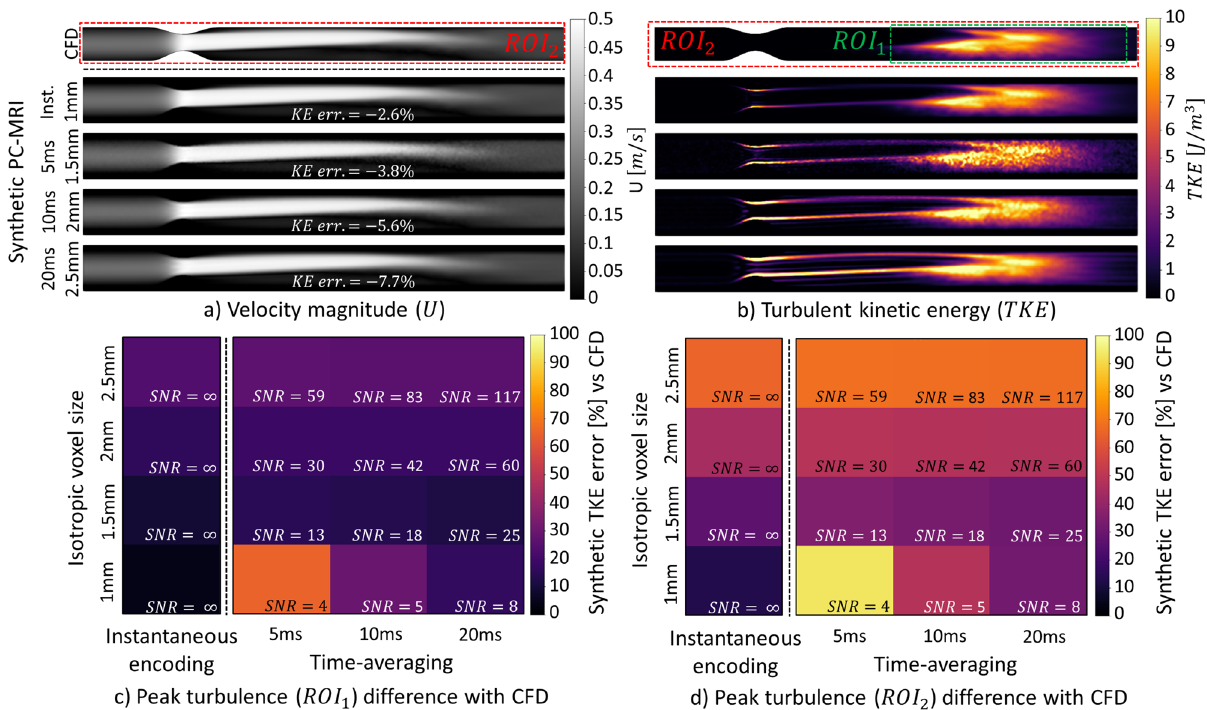
Figure 2. Impact of SNR and spatiotemporal resolution on velocity and turbulent kinetic energy for a 75% eccentric stenosis and steady flow. Magnitude of velocity ( U ) ( a ) and turbulent kinetic energy ( TKE ) ( b ) for varying voxel sizes, time averaging and, correspondingly, signal-to-noise ratios (SNR) are shown. The percentage error in total TKE as a function of spatial resolution, time averaging, and SNR is shown in ( c ) and ( d ) for ROI 1 (envelope of the turbulent region) and ROI 2 (whole geometry), respectively. Instantaneous (Inst.) encoding refers to a hypothetical noise-free PC-MRI experiment with infinitely high velocity encoding